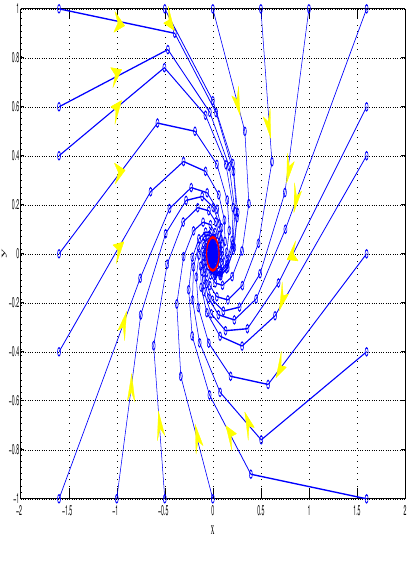
Figure 8. The numerical solutions generated by the NSFD scheme with h = 0 . 5 and t ∈ [0 , 100] in Example